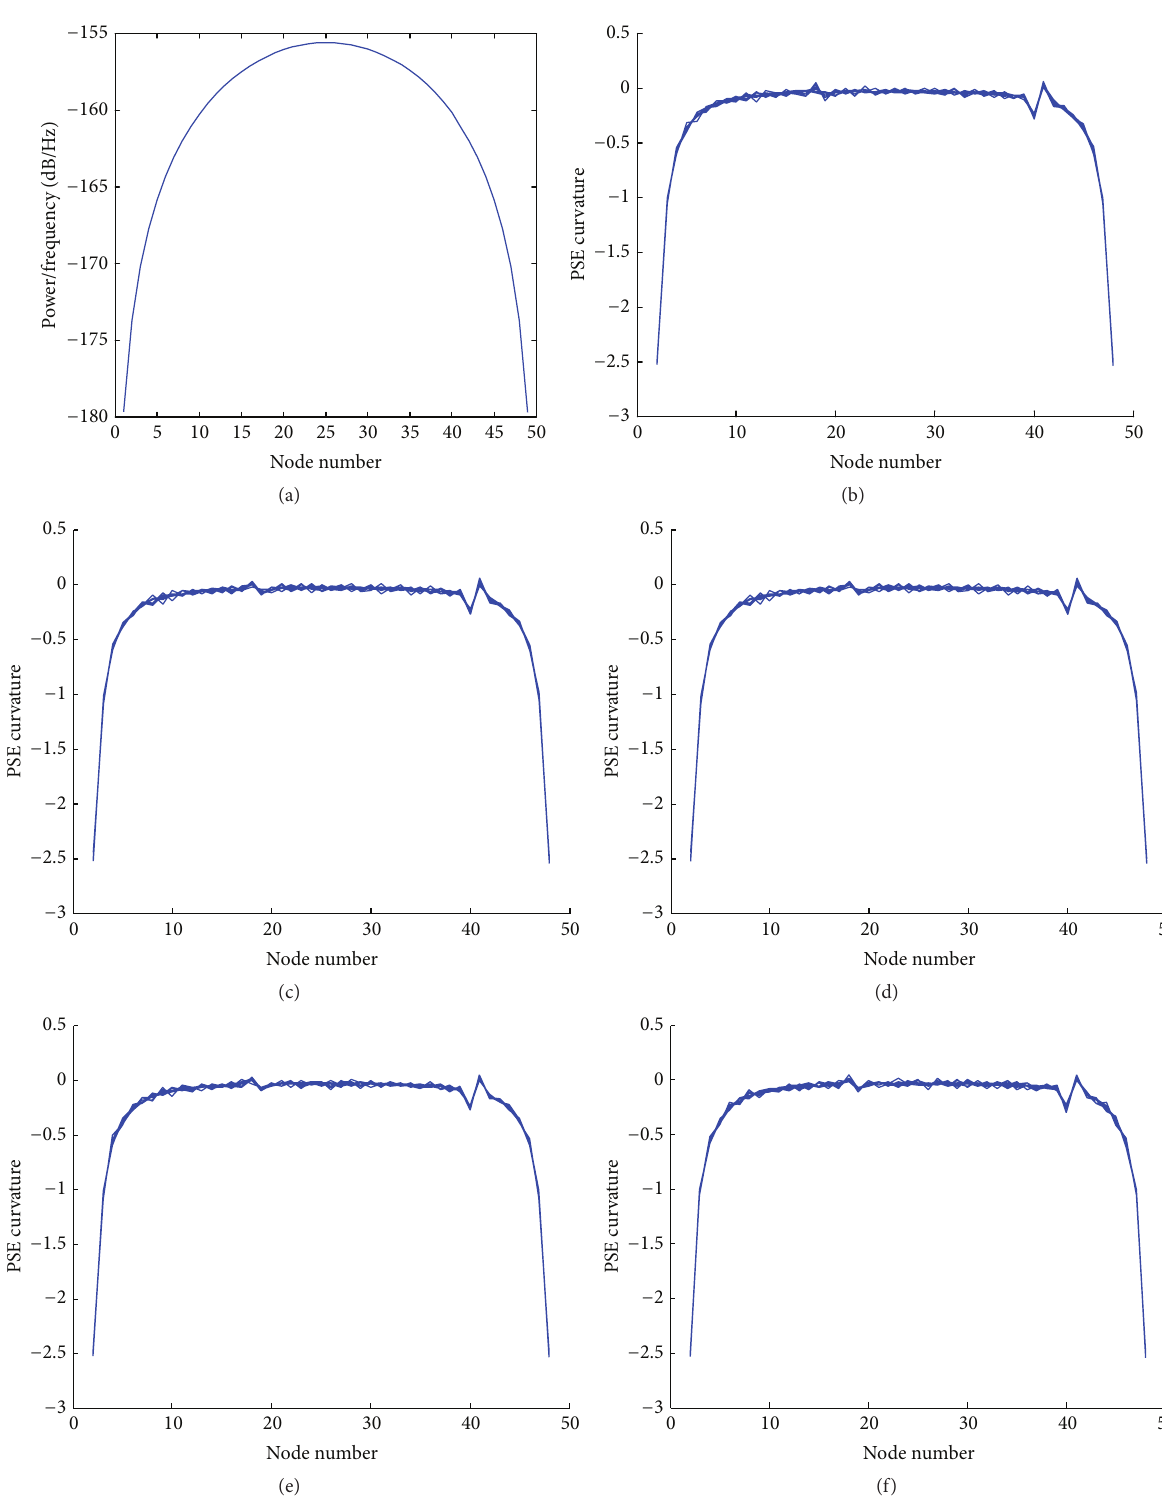
Figure 5: PSE curve and its curvature under the condition of Fr = 0.5 Hz: (a) PSE curve (rectangular window, 50% overlap) by maximum PSE values around 36 Hz/sample, (b) PSE curvature (rectangular window), (c) PSE curvature (Hamming window), (d) PSE curvature (Bartlett window), (e) PSE curvature (Hann window), and (f) PSE curvature (Blackman